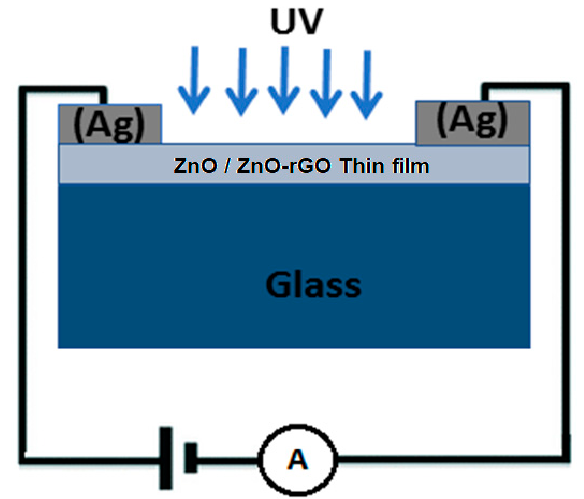
Figure 14. Diagram of ZnO and ZnO-rGO thin film to measure I–V curves in dark and with UV light .